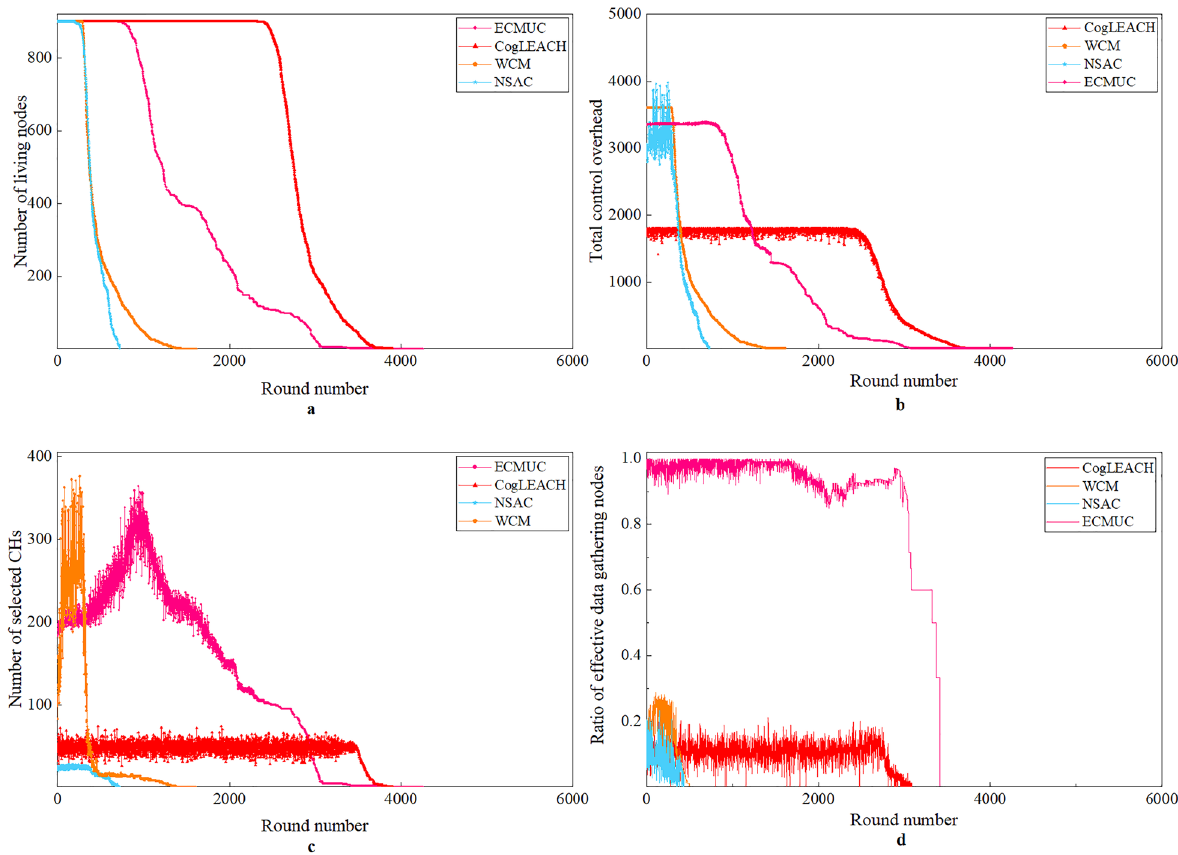
Figure 8. Performance comparison results in Case